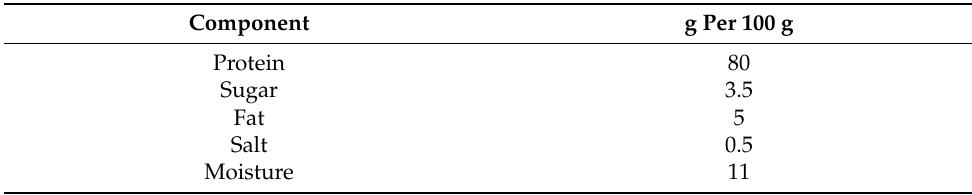
Table 1. Composition of whey protein powder provided by the manufacturer.